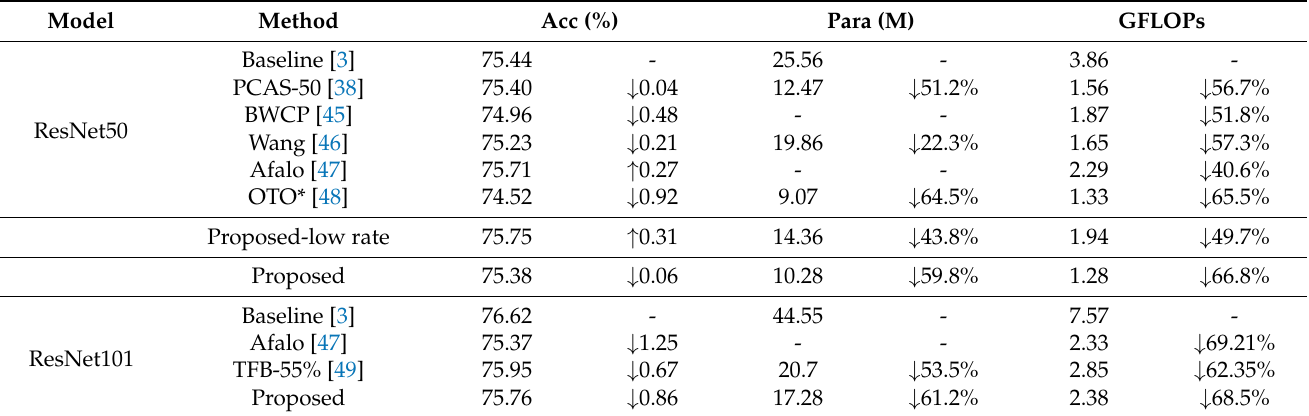
Table 2. Comparison of different pruning algorithms for different ResNet backbones on